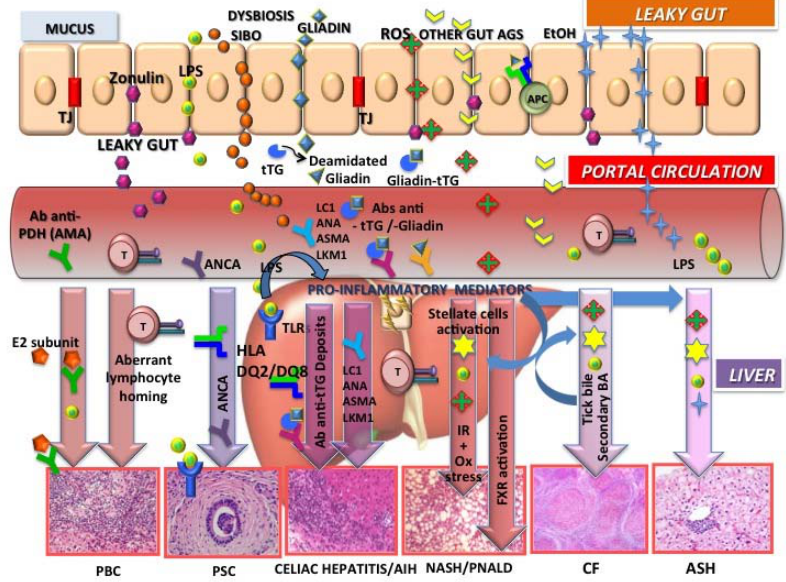
Figure 2. Gut ‐ liver axis and liver diseases. Increased intestinal permeability and dysbiosis are common features linking the liver to a number of nutritional/gastrointestinal (GI) diseases depicted in the figure. The toll ‐ like receptor (TLR)–bacterial lipopolysaccharide (LPS) interaction is one of the mechanisms involved in the release of proinflammatory mediators (cytokines), leading to liver inflammation and stellate ‐ cell ‐ activation ‐ dependent fibrosis. Emerging therapeutic approaches that target the gut ‐ liver axis therefore represent promising therapies to prevent or halt liver disease progression.